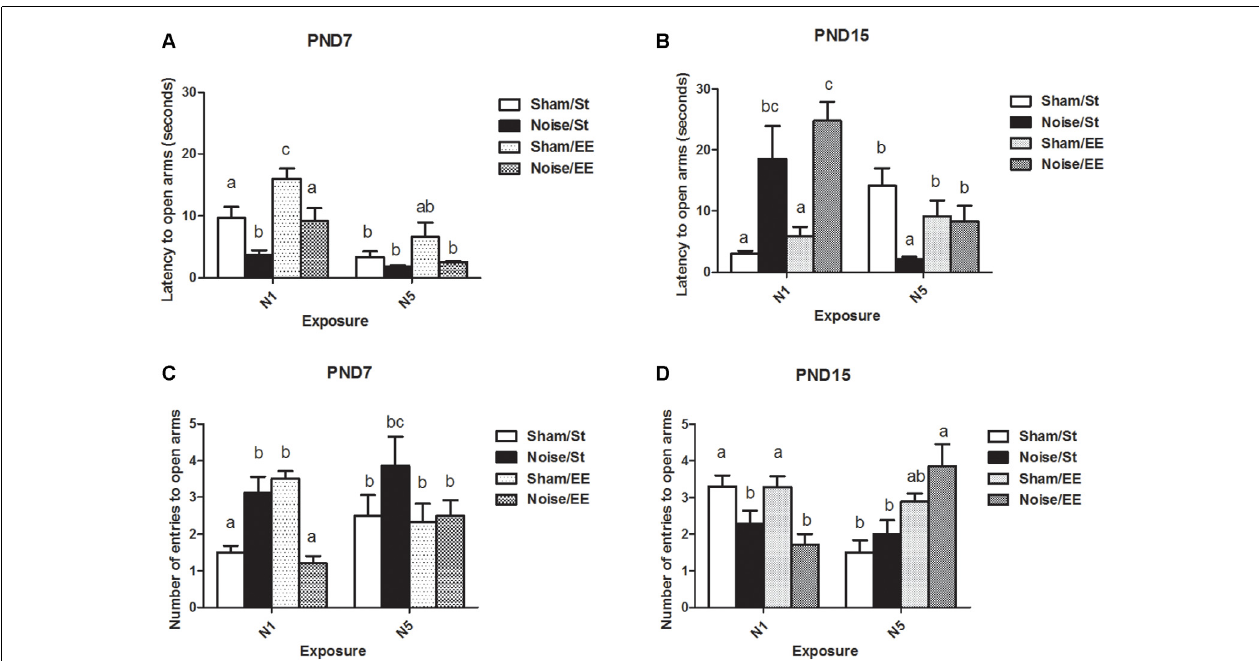
FIGURE 6 | Anxiety-related behaviors measured in the elevated plus maze (EPM; latency and number of entries to open arms) of PND28 animals exposed to noise at PND7 and PND15 in the EPM task. Latency to open arms (in seconds): (A) PND28 animals exposed at PND7; (B) PND28 animals exposed at PND15. Entries to open arms: (C) PND28 animals exposed at PND7; (D) PND28 animals exposed at PND15. Sham: non- exposed animals; N1: single noise exposure; N5: five-daily noise exposure. St: standard housing. EE: enriched environment. Different letters (a, b, c) symbolize significant differences with p < 0.05. Data represent the mean ± SEM of latency (seconds) or entries to open arms made in the EPM task, n = 7 for each